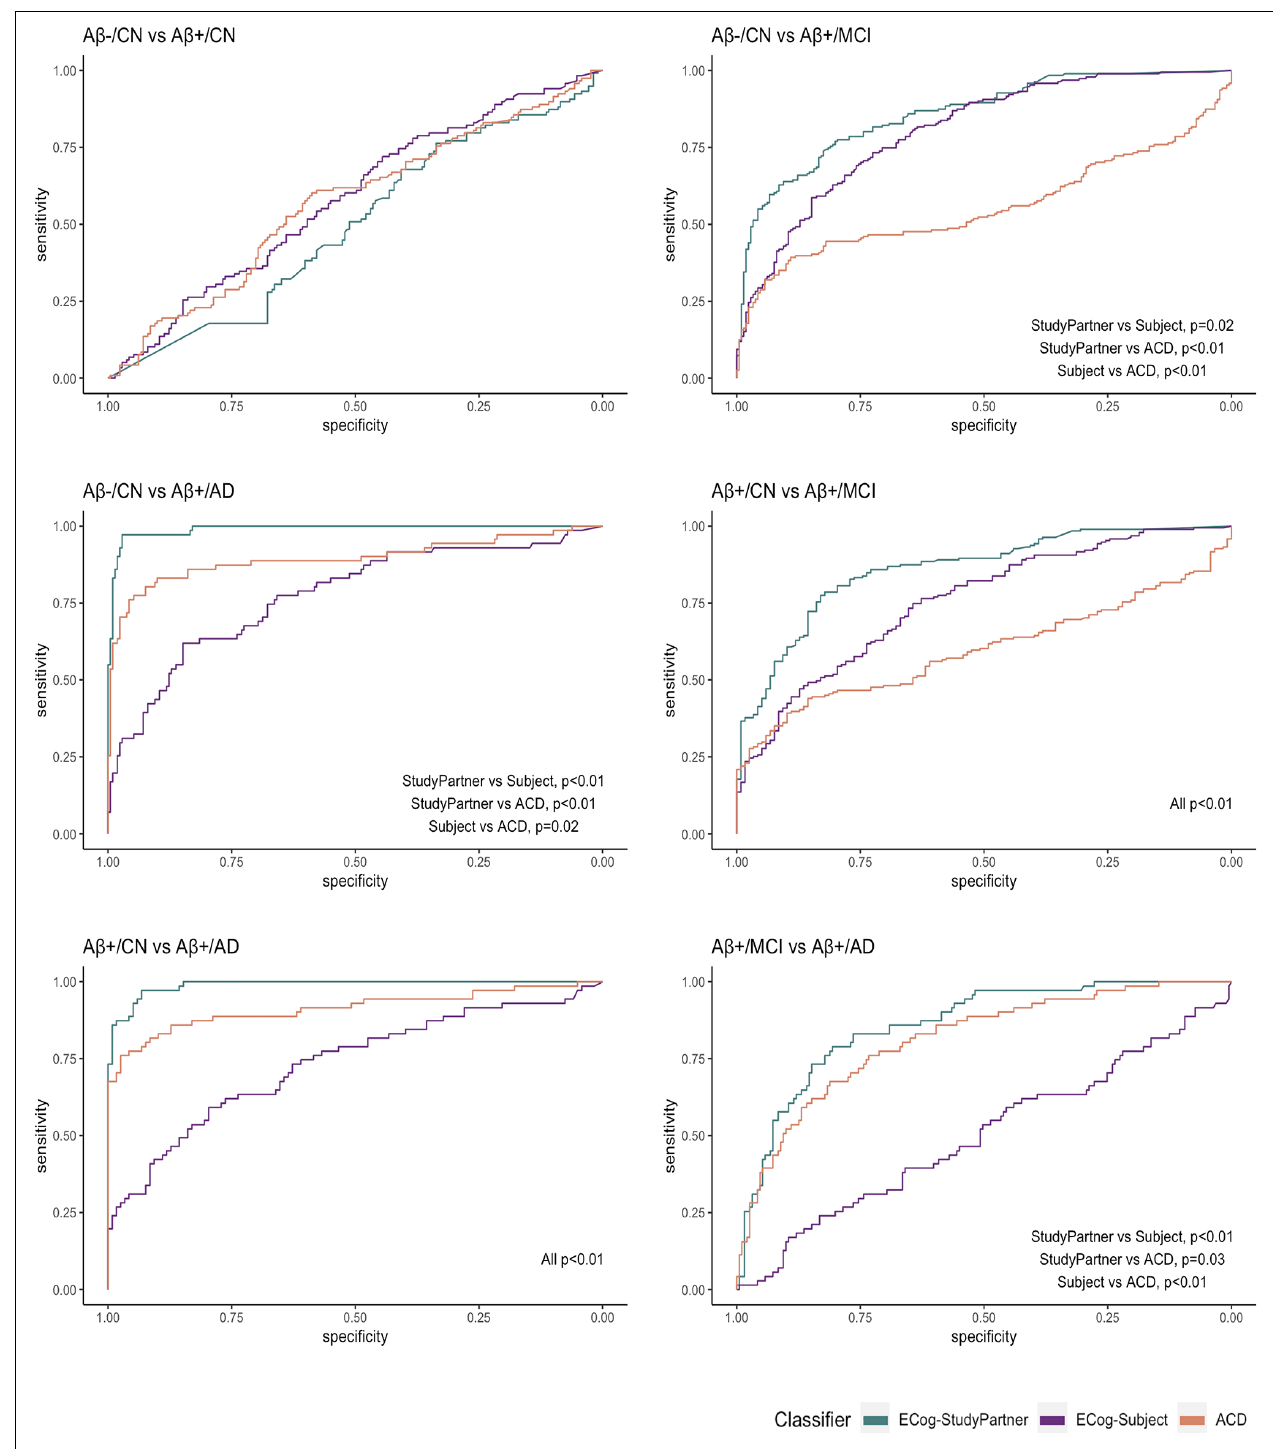
FIGURE 2 | ROC comparisons between the three sources of information.